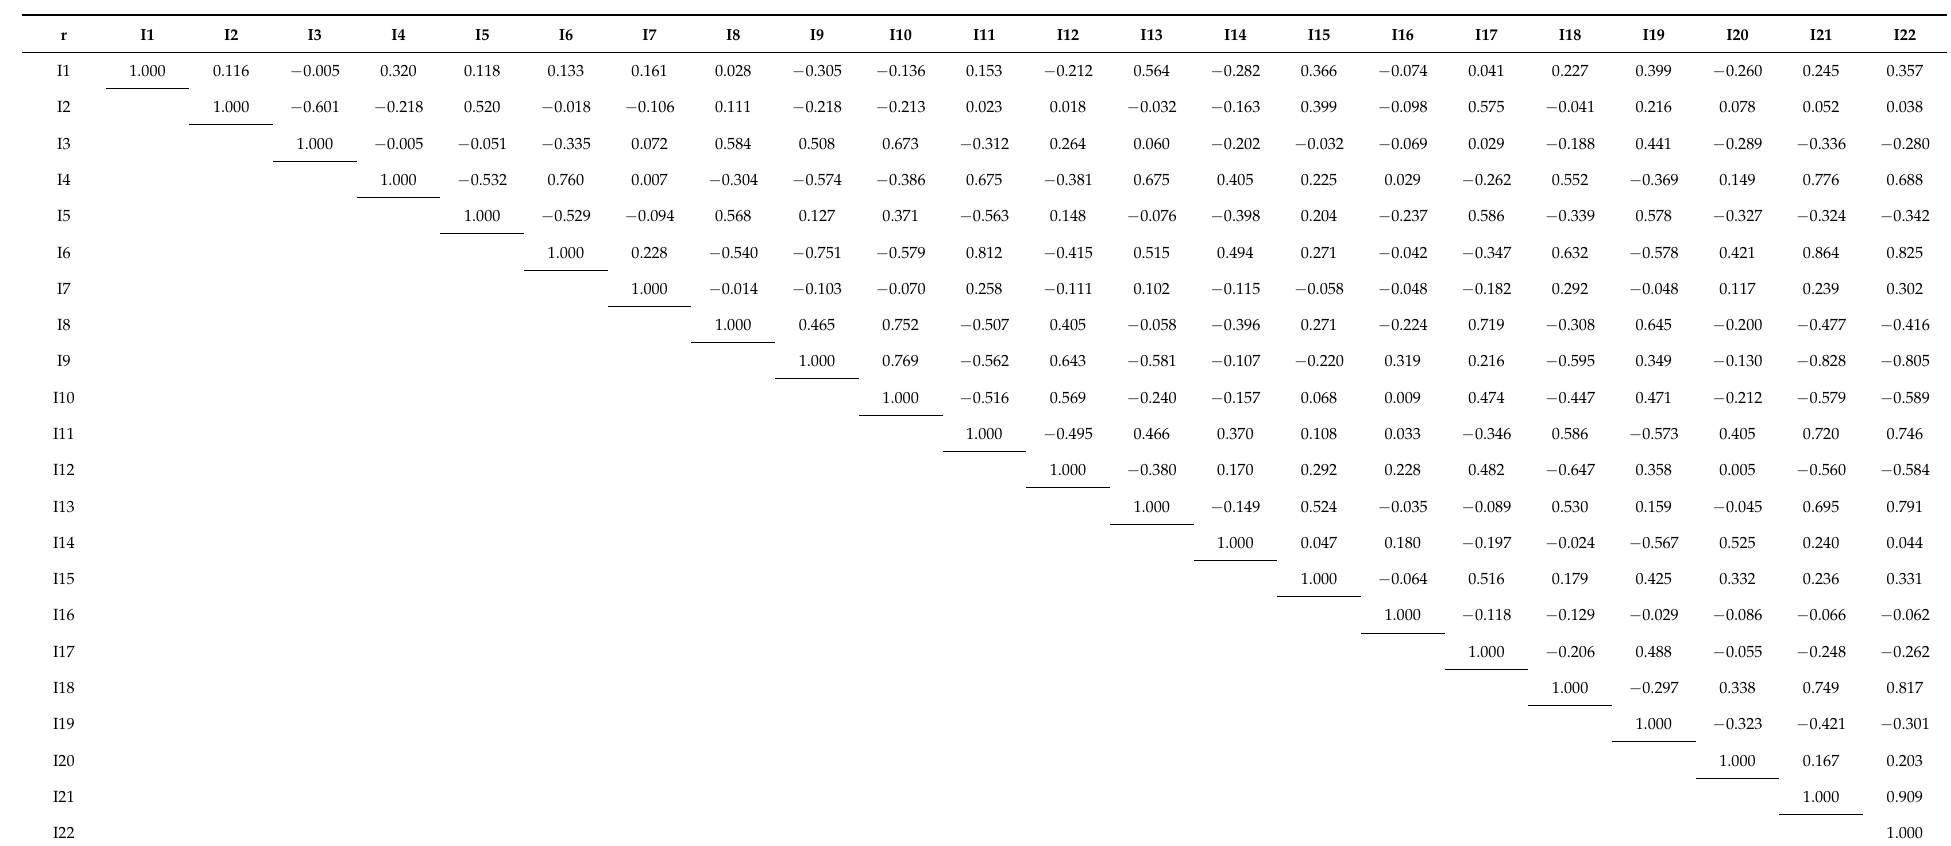
Table A1. The interdependence among resilient indicators derived from Pierson coefficient of correlation